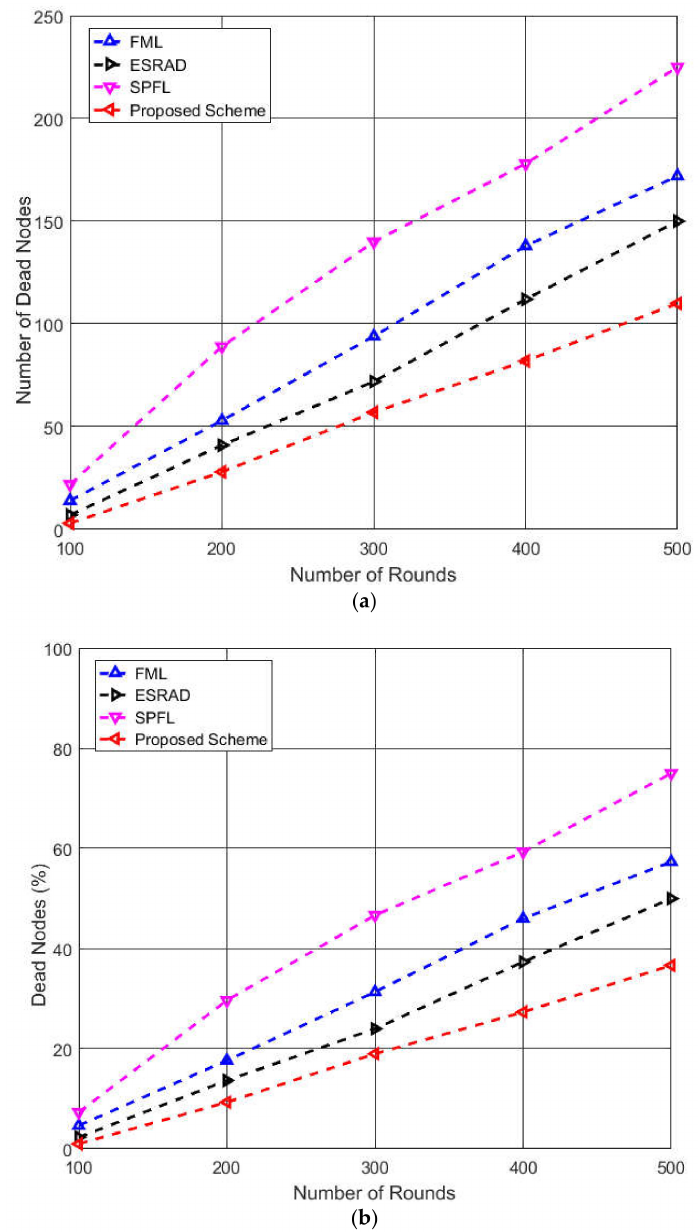
Figure 6. Performance comparison of network lifetime of the four algorithms: ( a ) number of dead nodes with respect to number of rounds; ( b ) percentage of dead nodes corresponding to specific number of